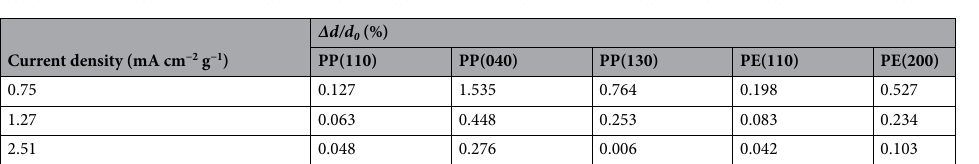
Table 2. The d- spacing difference (%) for different planes at difference C-rate. Δd = d f − d 0 , spacing difference. d f , the spacing at fully charged condition. d 0 , the spacing before charging